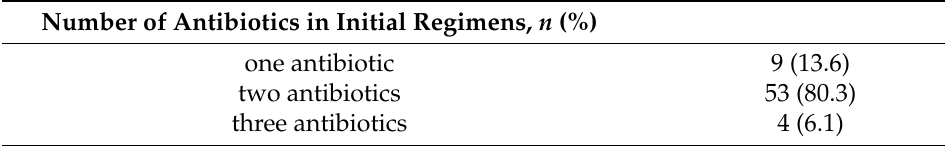
Table 5. Antibiotic regimens and combinations of colistin ( n = 66).